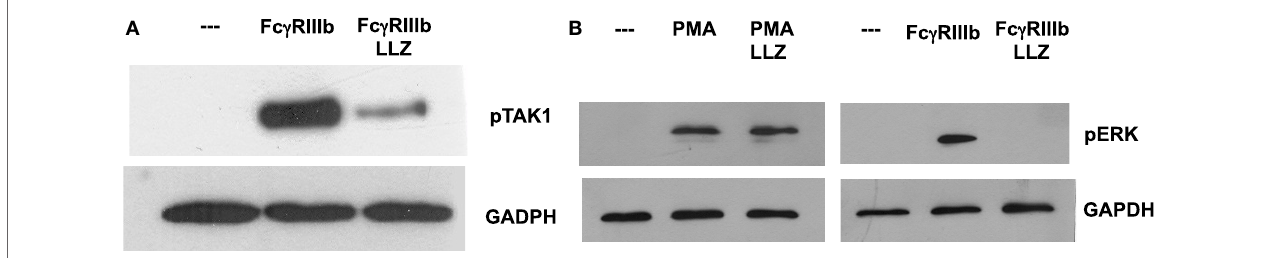
FigUre 6 | TaK1 is required for Fc γ riiib-mediated erK activation . Human neutrophils were left untreated (---), or were stimulated by cross-linking Fc γ RIIIb for 15 min, or by 20 nM phorbol 12-myristate 13-acetate (PMA). Some neutrophils were previously treated with 10 nM LL Z1640-2 (LLZ), a selective inhibitor of TAK1. Cell lysates were prepared after stimulation. Proteins were resolved by SDS-PAGE, and then, Western blotted for (a) phosphorylated-TAK1 (pTAK1) (upper panel) and for total glyceraldehyde 3-phosphate dehydrogenase (GAPDH) (lower panel); or for (B) phosphorylated ERK (pERK) and total GAPDH (lower panel). Data are representative of three separate